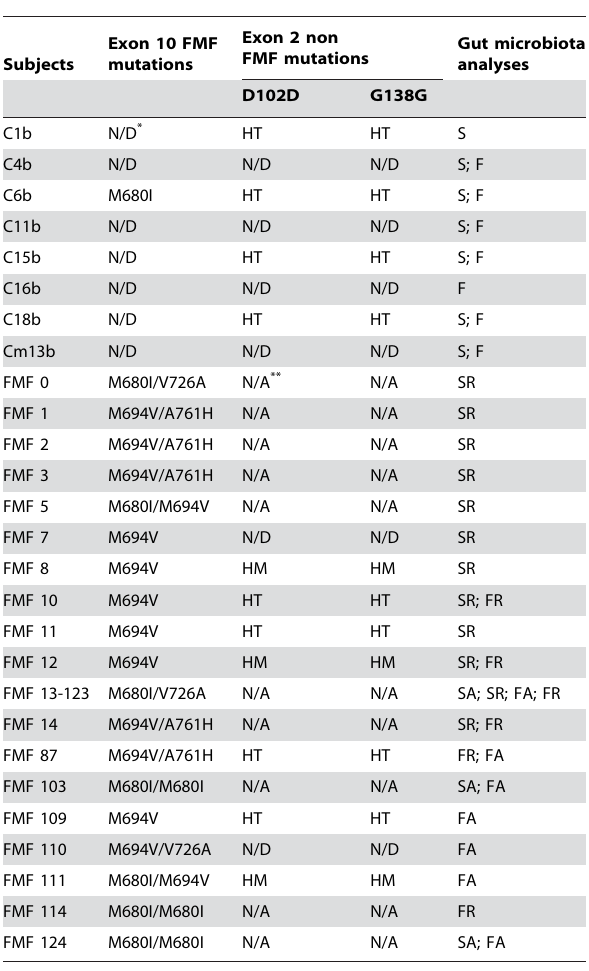
Table 2. Phylogenetic distribution of 16S rRNA gene sequences and phylotypes retrieved from healthy individuals and FMF patients in remission and attack.